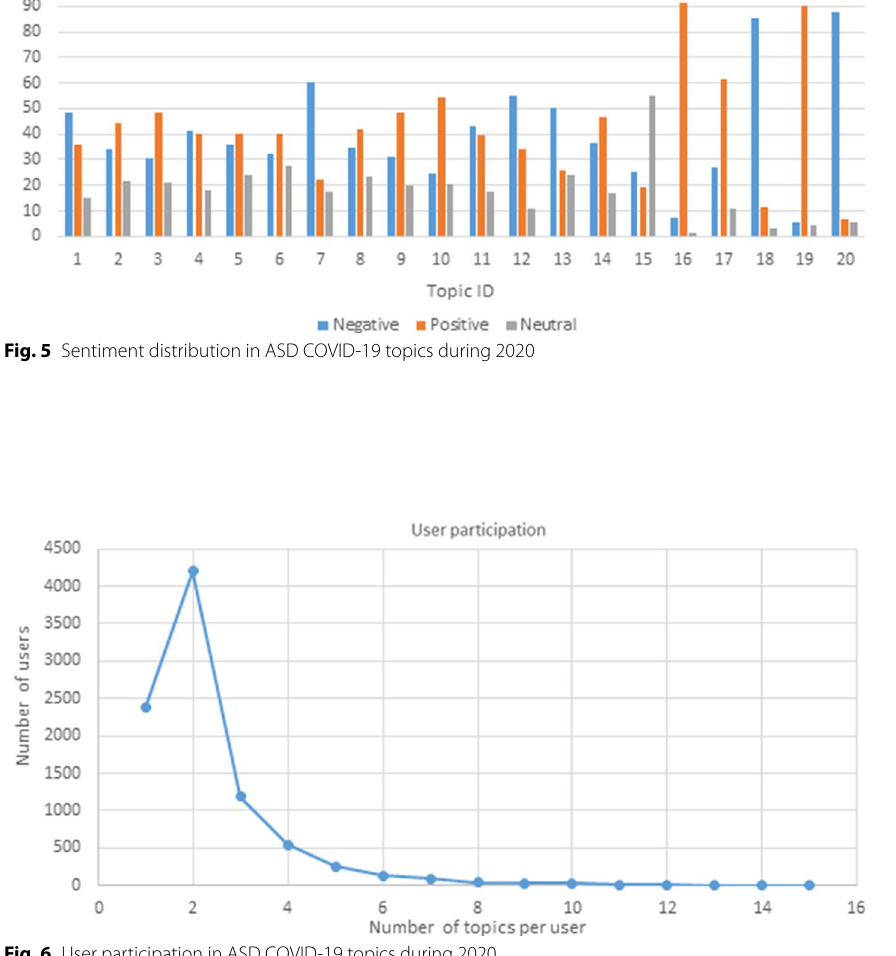
Fig. 6 User participation in ASD COVID-19 topics during